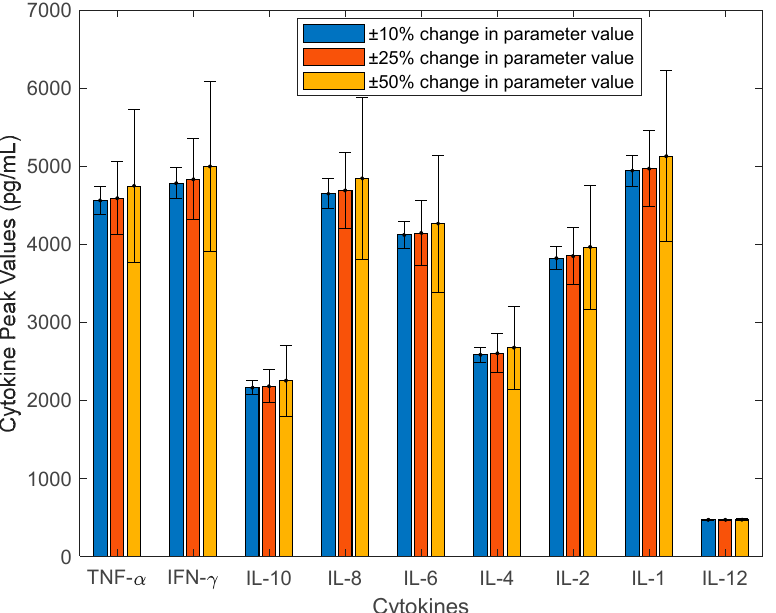
Figure 3. The mean peak concentration of all 9 cytokines along with one standard deviation represented by the error bar that were generated in the Monte Carlo sampling of the TGN1412 trial.